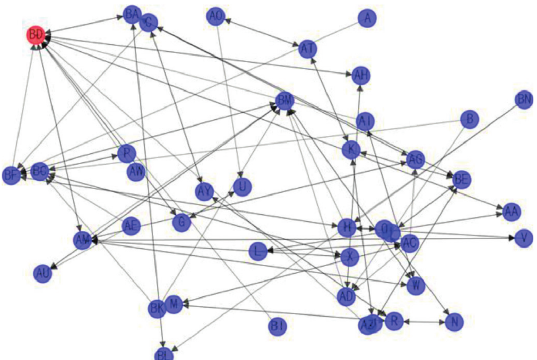
Figure 8: The cause and effect diagram of the partial process of SMMB flight guarantee.